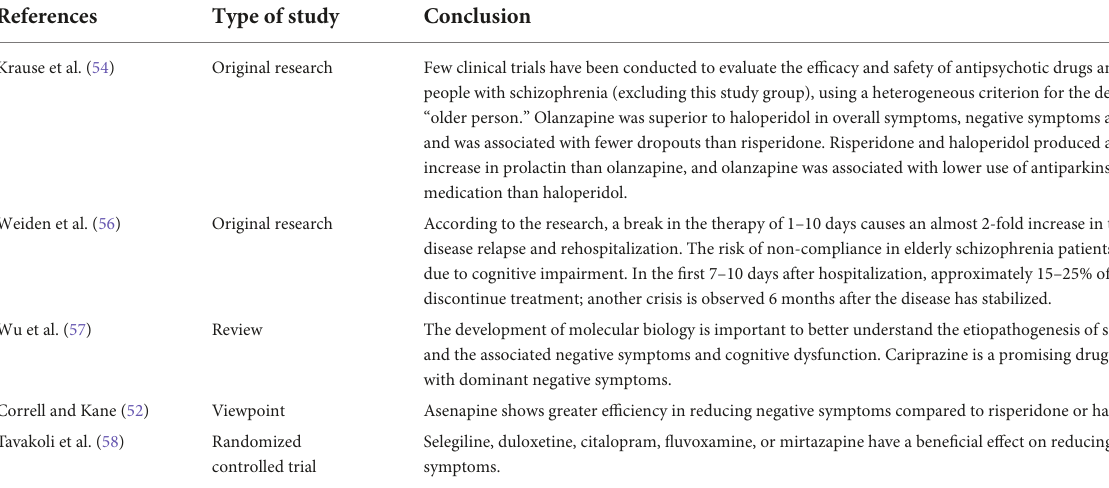
TABLE 6 Summarizing articles about schizophrenia with onset at different ages.